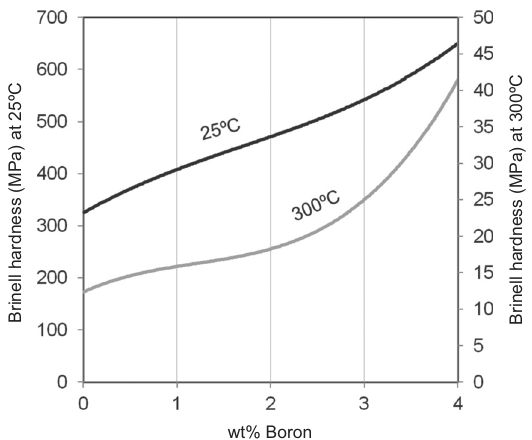
Figure 3 Brinell hardness at 300 ° C and room temperature as a function of the boron level present in Al-Cu matrix composites.